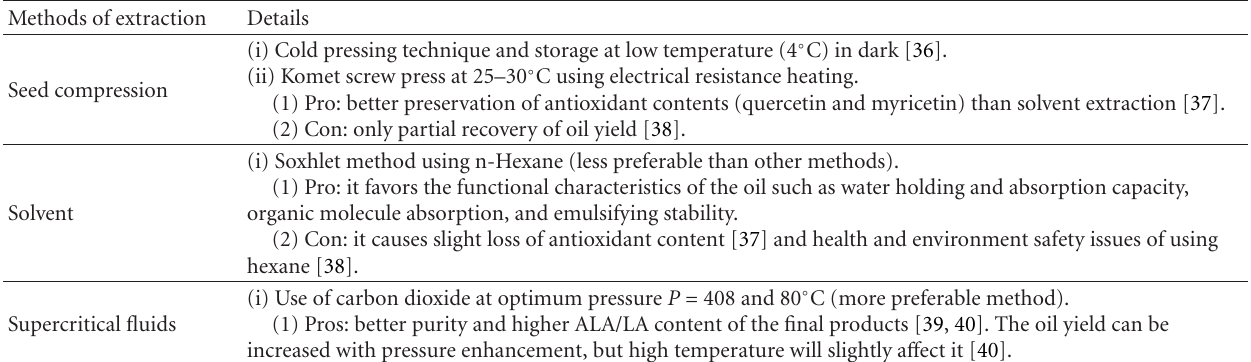
Table 3: Extraction of oil from chia